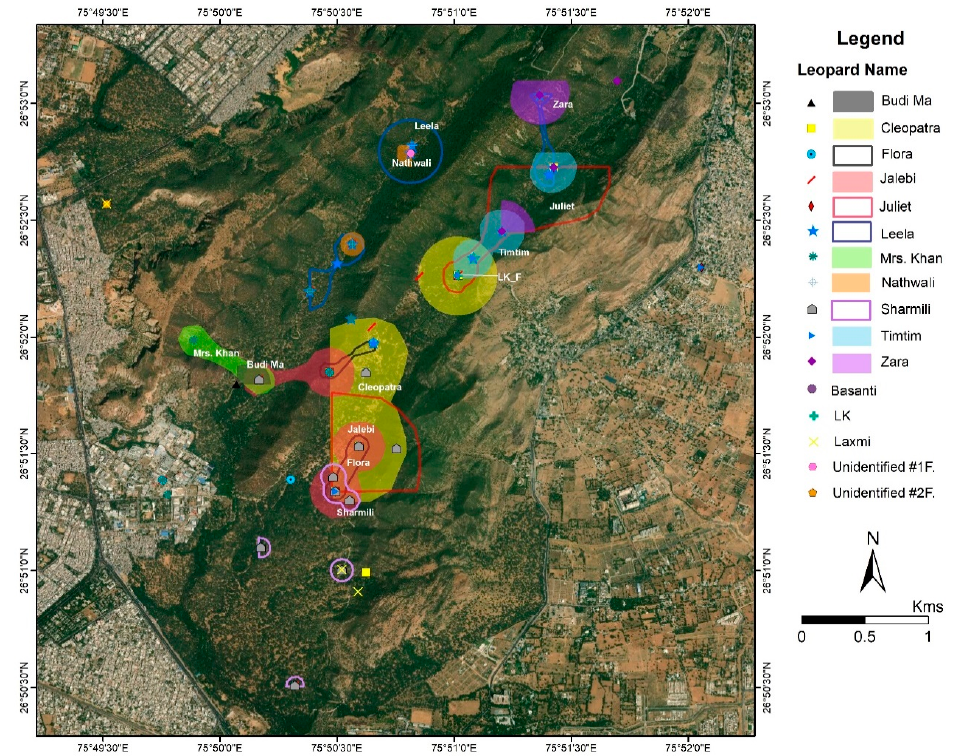
Figure 8. Kernel density analyses of 50% of clustered camera-trap photos of the female leopards in Jhalana Forest Reserve. Animals 2020 , 10 , x FOR PEER REVIEW